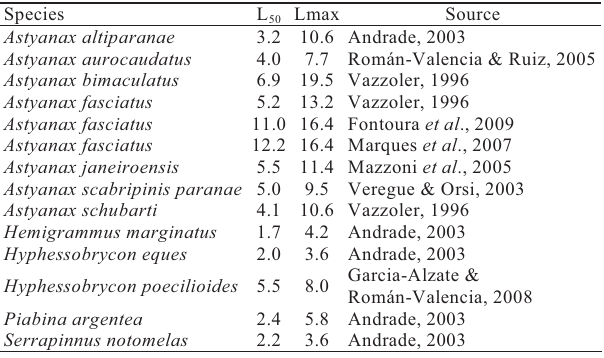
Table 1. Size at first maturity (L length (Lmax) for characid